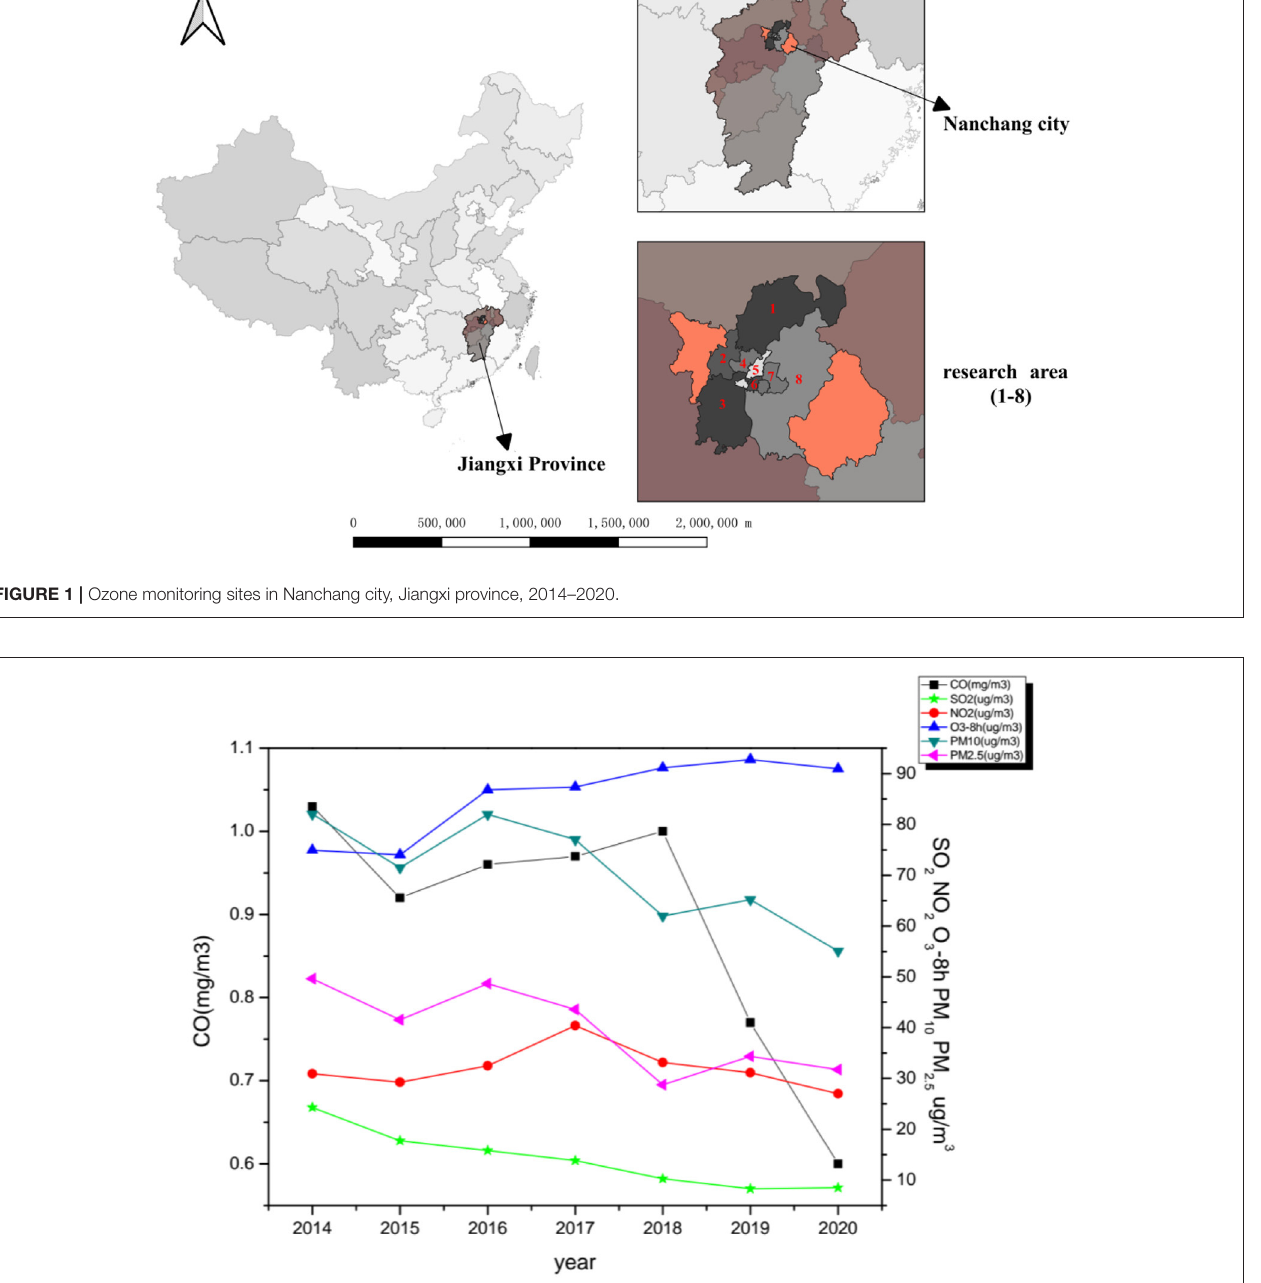
it is focused on that under different hysteresis models with the average concentration of O 3 -8h increase of 10 µ g/m 3 leads to respiratory mortality and cardiovascular mortality (ER,95%CI). For the single lag model, the strongest effect of O 3 -8h on respiratory mortality and cardiovascular mortality on the